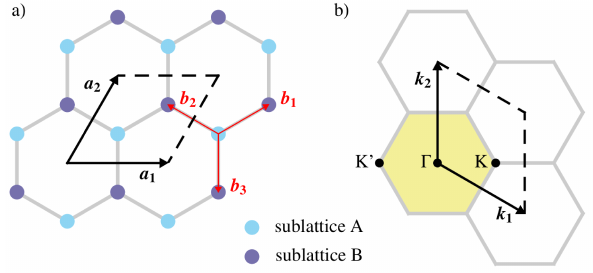
Figure 1: Honeycomb lattice of graphene. (a) Equivalent sublat- tices A and B of the two carbon atoms in the unit cell defined by the primitive lattice vectors a 1 and a 2 . (b) Reciprocal lattice with the reciprocal lattice vectors k 1 and k 2 , the Brillouin zone (yellow area), and the high symmetry points Γ , K, and